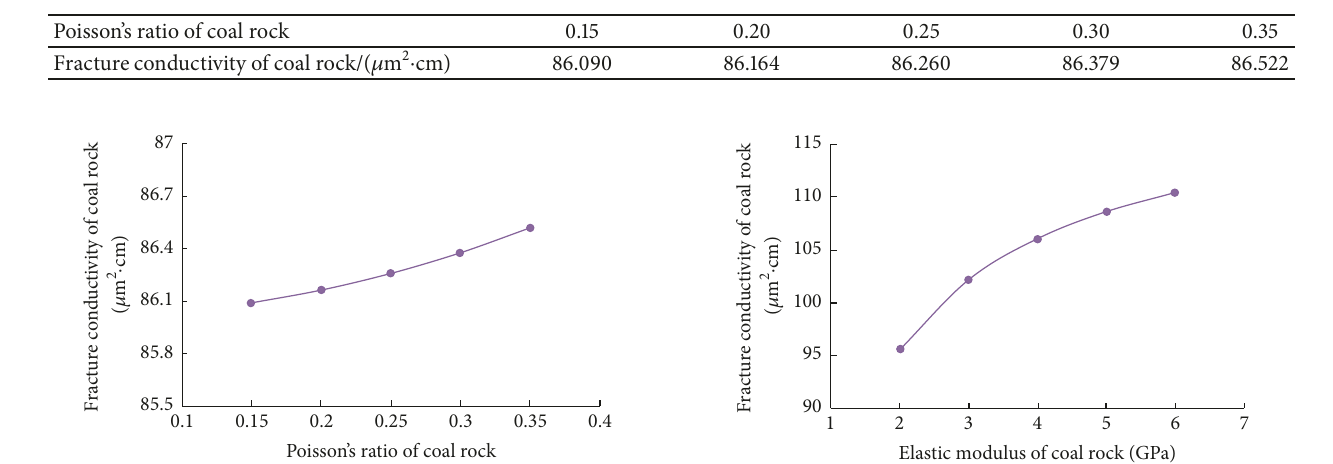
Table 3: Fracture conductivity under different Poisson’s ratio of coal rock.